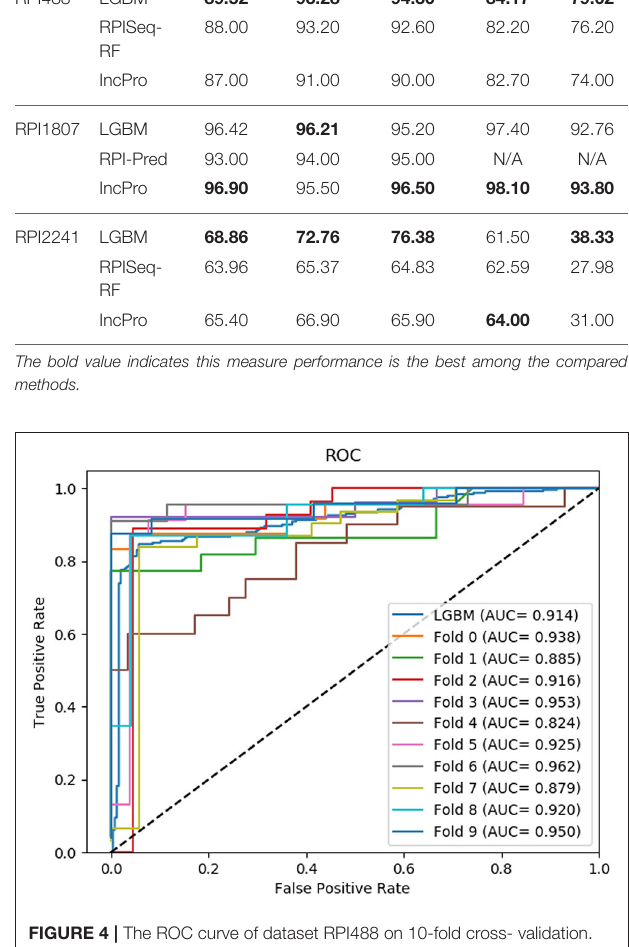
FIGURE 6 | The ROC curve of dataset RPI2241 on 10-fold cross-